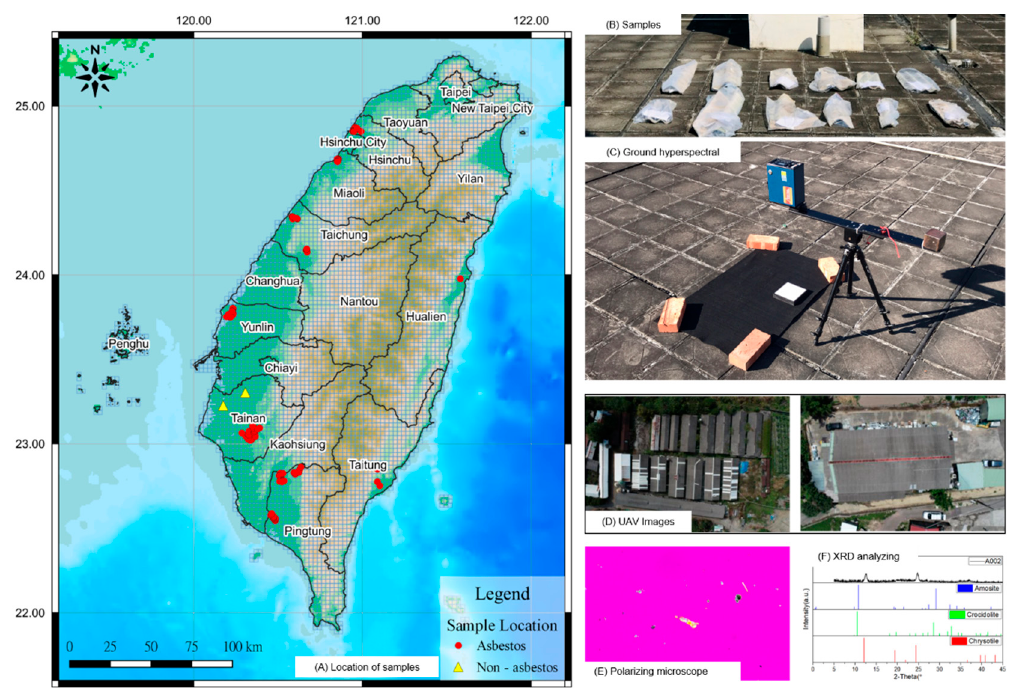
Figure 3. Sample locations of the asbestos-cement corrugated roofing tiles as well as equipment for ground multispectral scanning.